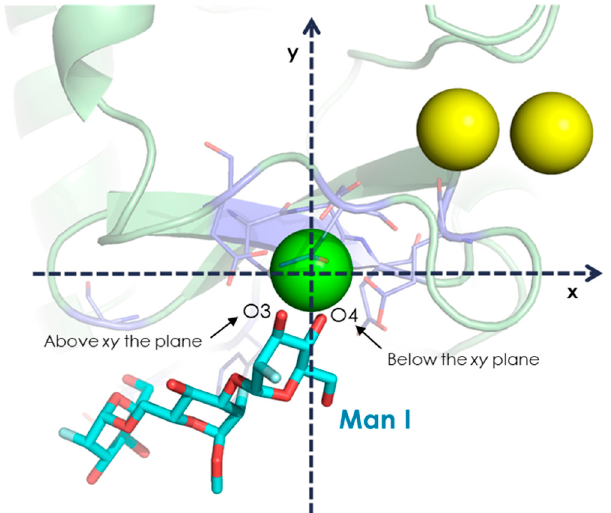
Figure 3. Schematic view of one possible complex between 1 and DC-SIGN describing the employed Cartesian system to describe the coordinating oxygen atoms. The geometric center of the three Ca 2+ ions of DC-SIGN is on the xy plane, the key Ca 2+ (green sphere) is set at the origin, and the other two ions (yellow spheres) are placed in the first quadrant. The coordinating oxygen closer to the viewer is first specified (O3 in this case), and the other one (O4) is named later. Therefore, this binding pose is “ManI_O3-O4”. Table 3. Modelled structures for MD simulations. The stability of the different complexes is also given as the association time averaged for the different MD replicas (6–12 replicas of 400 ns each). The